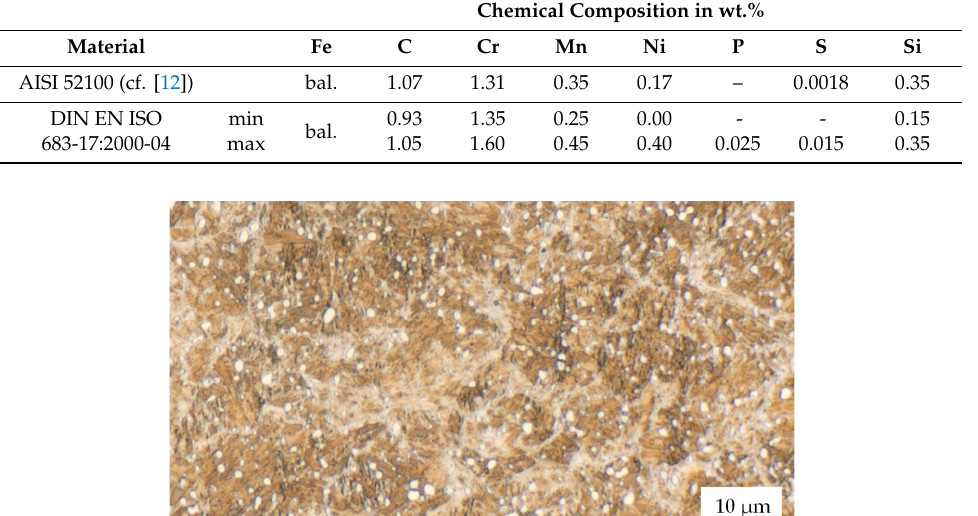
Table 1. Average chemical composition of the roller balls used for the experimental work cf. [12]. Chemical Composition in wt.%